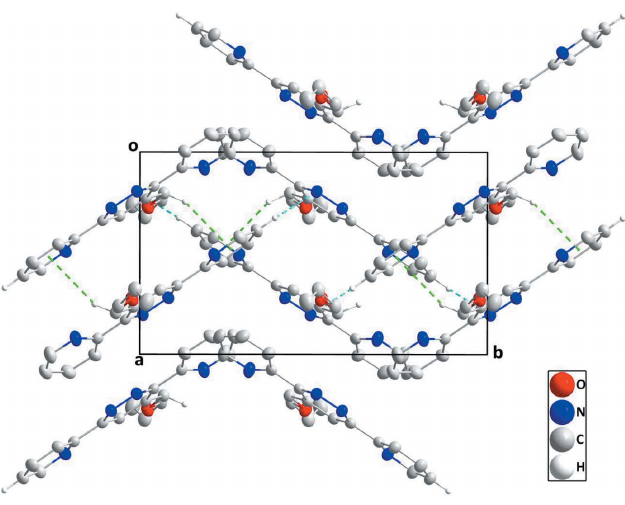
Figure 3 A partial packing diagram viewed along the c -axis direction with